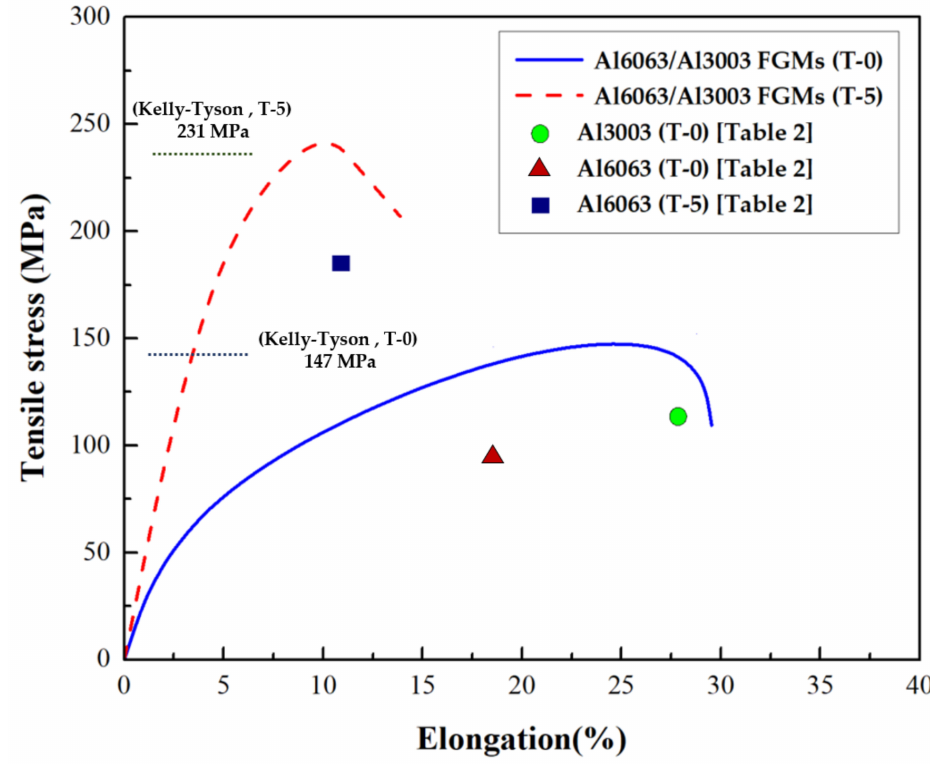
Figure 9. Stress and strain graph of Al3003/Al6063 FGMs (T-0 and